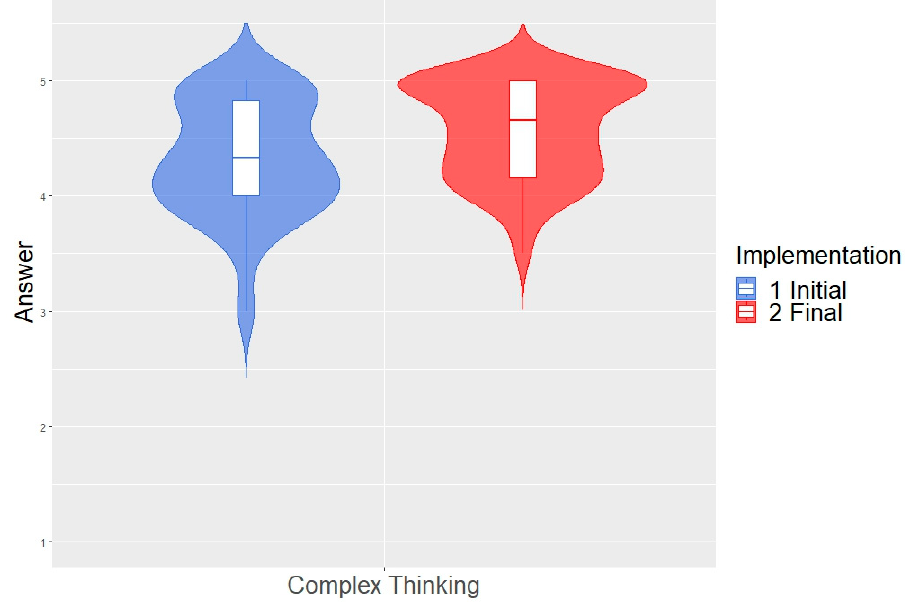
Figure 2. Results of the complex thinking competency (Initial–Final).